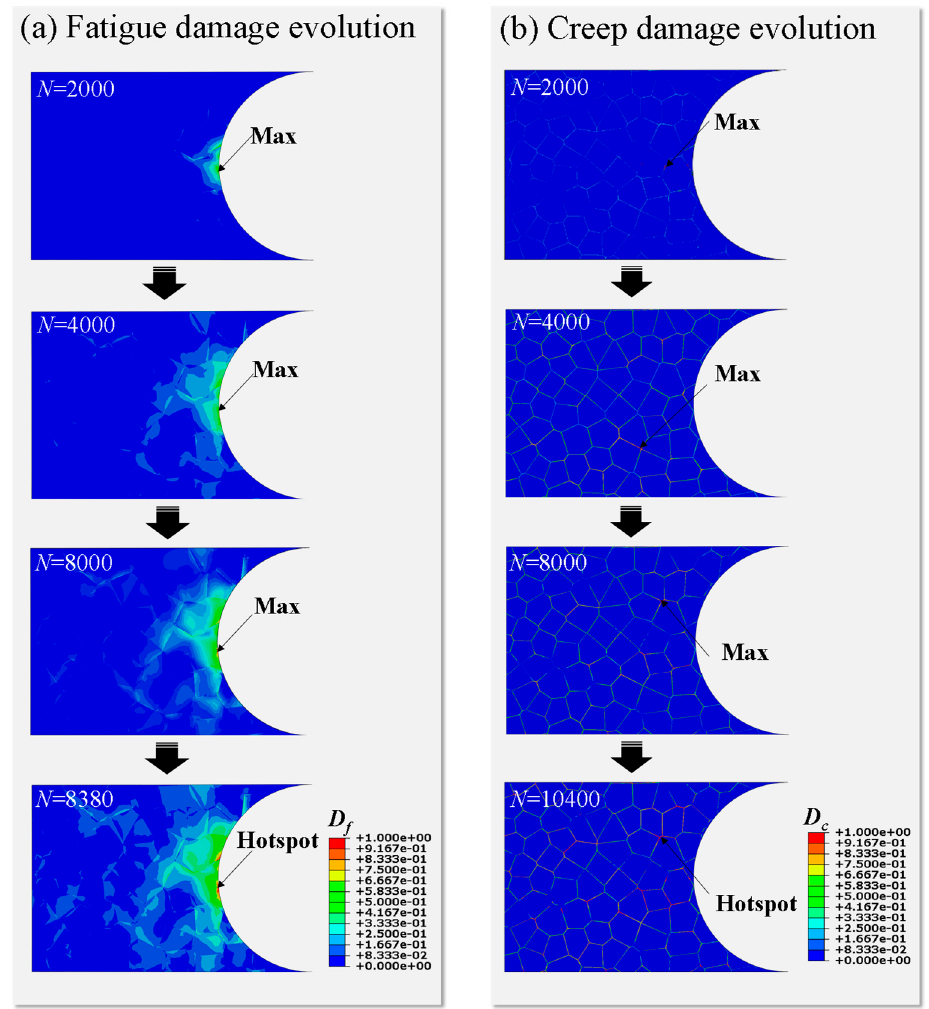
Figure 14. Evolution of ( a ) fatigue and ( b ) creep damage for holding time t d = 800 s.